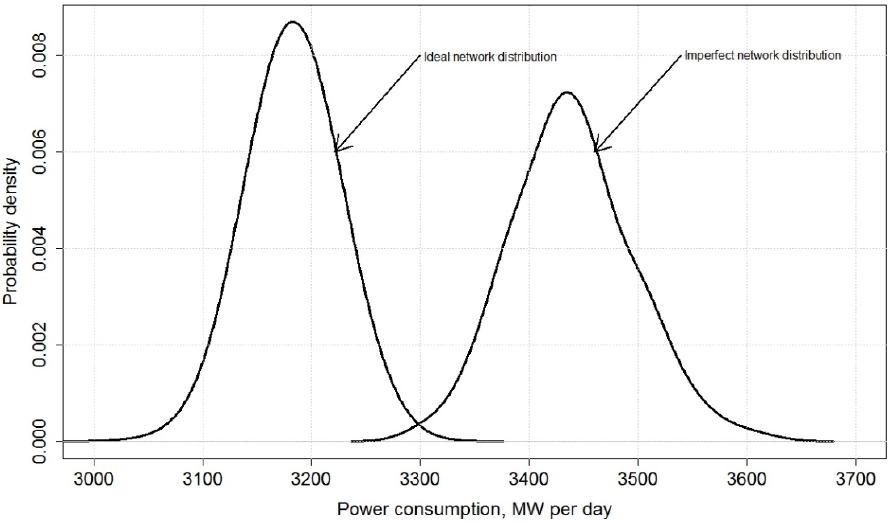
Figure 8. Distributions of average power consumption in different networks over 25 years.